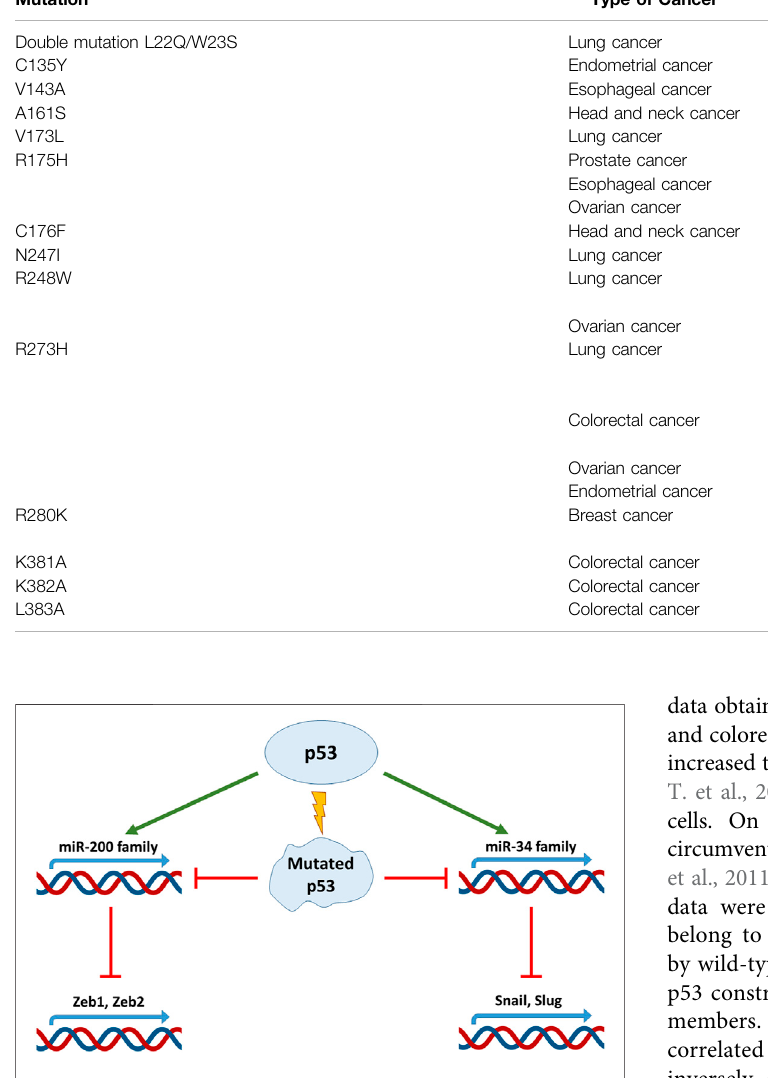
FIGURE 1 | p53 regulates EMT factors through micro-RNA. The p53 protein directly regulates the expression of miR-200 and miR-34 micro-RNA families decreasing Zeb and Snail expression respectively. Mutations in TP53 gene disrupt this link and promote EMT.